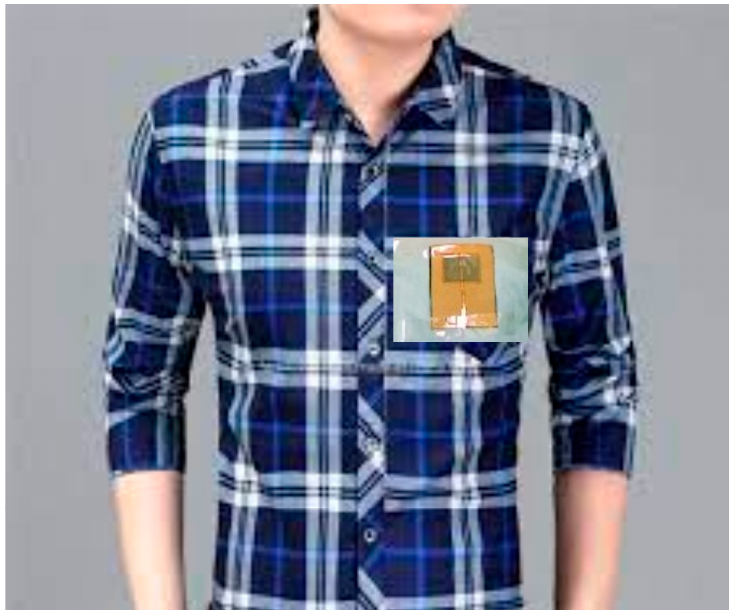
Figure 1. A clumsy, wearable patch antenna attached to a shirt with a plastic, transparent sheet; computer simulation based on